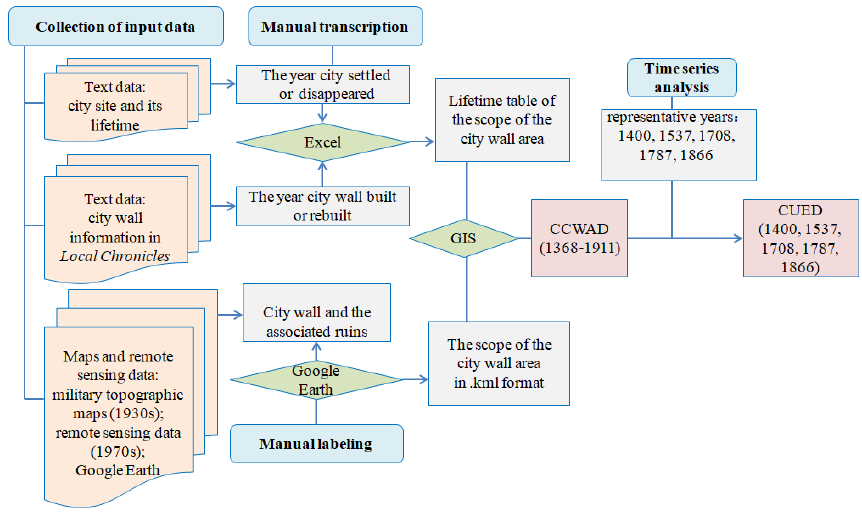
Figure 4. A flowchart of the methodology used to generate the China City Wall Areas Dataset (CCWAD) and China Urban Extent Dataset (CUED) for the 15th–19th centuries in late imperial